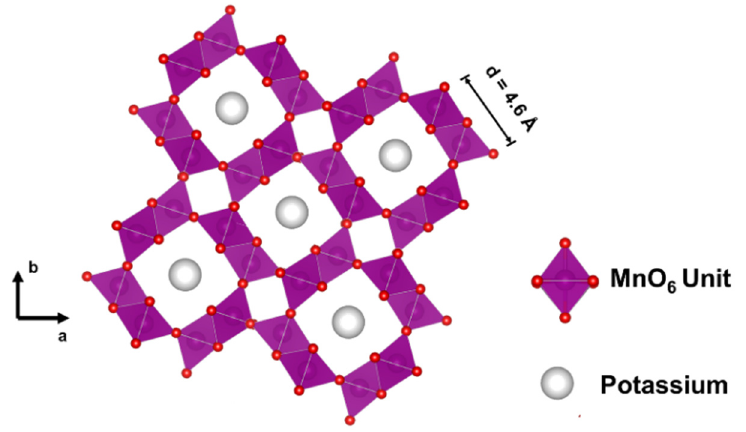
Figure 4. Schematic representation of the crystal structure of K–OMS–2. Cell dimensions are indi- cated.